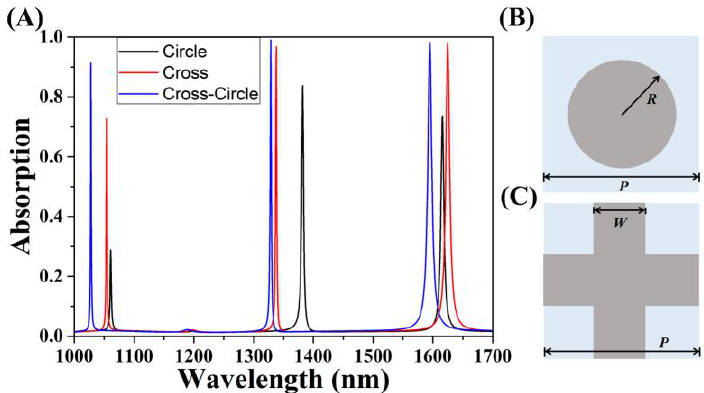
Figure 2. ( A ) Absorption of the cross, circle, and cross-circle-shaped single-structure graphene absorbers. ( B ) Top view of the circle-shaped single-structure graphene absorber with a radius R . ( C ) Cross-shaped single-structure graphene absorber with a width W . The periods of the above two structures were P .